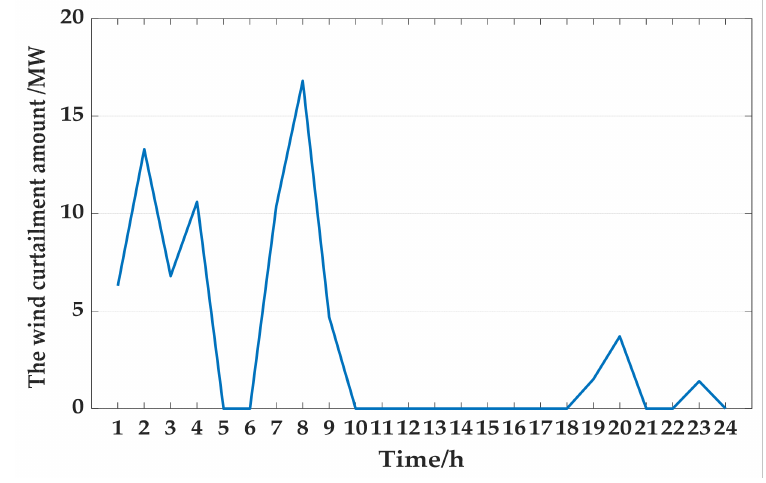
Figure 11. The wind curtailment amount without DR participation in Case 3. Table 6. The impacts of DR participation on system dispatch cost